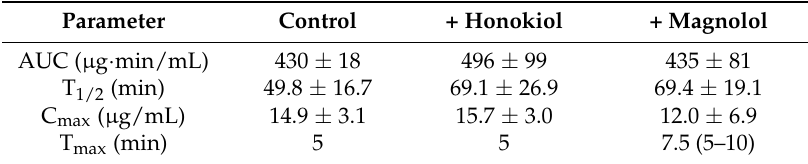
Table 2. Pharmacokinetic parameters of diclofenac in rats following its oral administration at a dose of 6 mg/kg with or without 5 mg/kg intravenous honokiol or magnolol ( n = 4‒5).